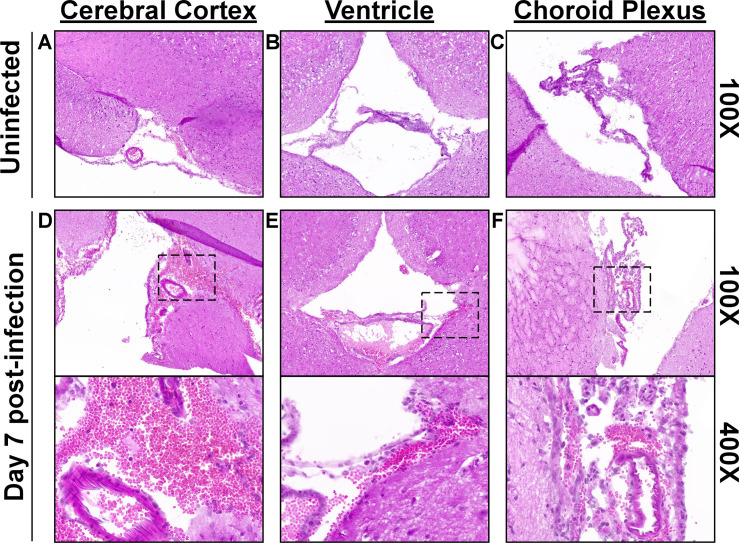
Infection with B. burgdorferi is associated with perivascular hemorrhage admixed with leukocytes in the leptomeninges and ventricles, without leukocytic infiltration into the brain parenchyma.Uninfected mice showed no microscopic evidence of inflammation in brain sections examined (A-C), while perivascular hemorrhage with attendant leukocytes was observed in the cerebral meninges (D), ventricles extending into the subependymal zone (E), and throughout the choroid plexus (F) at day 7 post-infection. Leukocytic infiltration was not noted in the cerebral cortex, hippocampus, or thalamus in either control or infected mice. Infection status is shown to the left of panels, while magnification is shown on the right. Boxed areas from 100X images show areas used for high magnification. See S13–S21 Figs for full resolution images.